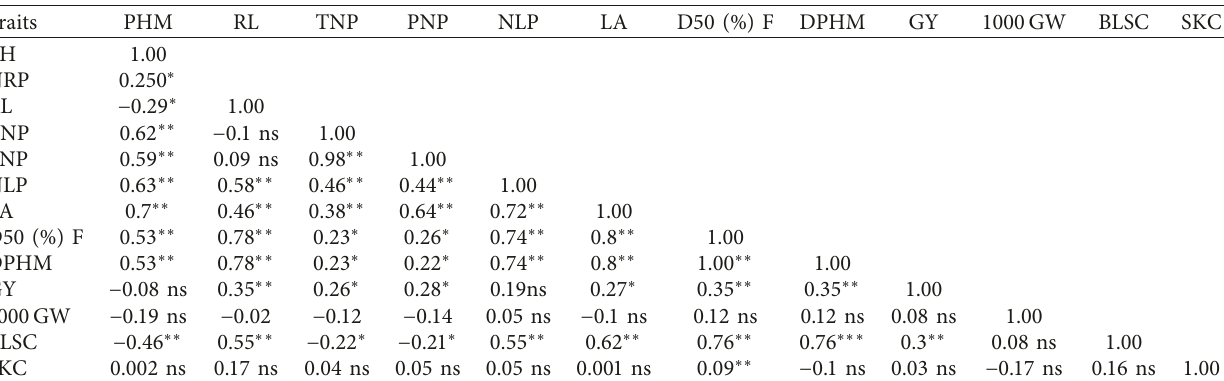
Table 9: Correlation among agro-morphological